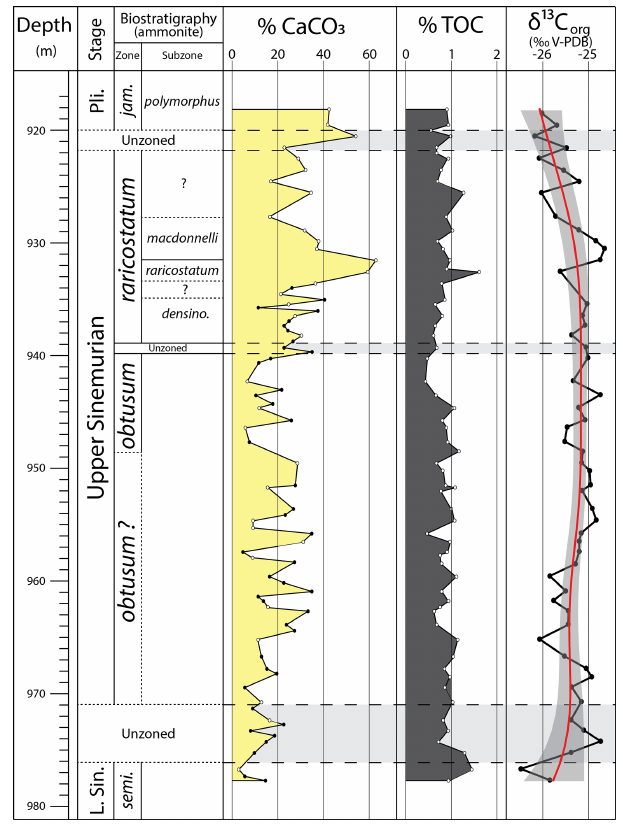
Figure 8. Carbon isotopic ratio ( δ 13 C org ) of the upper Sinemurian strata of the Montcornet borehole coupled to CaCO 3 and TOC pro- portions. The smoothing curve is in red, and the 95% confidence interval is in grey (kernel regression). Abbreviations: densinod. – densinodulum , L. Sin. – lower Sinemurian, macdonn. – macdon- nelli , Pli. – Pliensbachian, polymor. – polymorphus , raricost. – rari- costatum , semi. – semicostatum